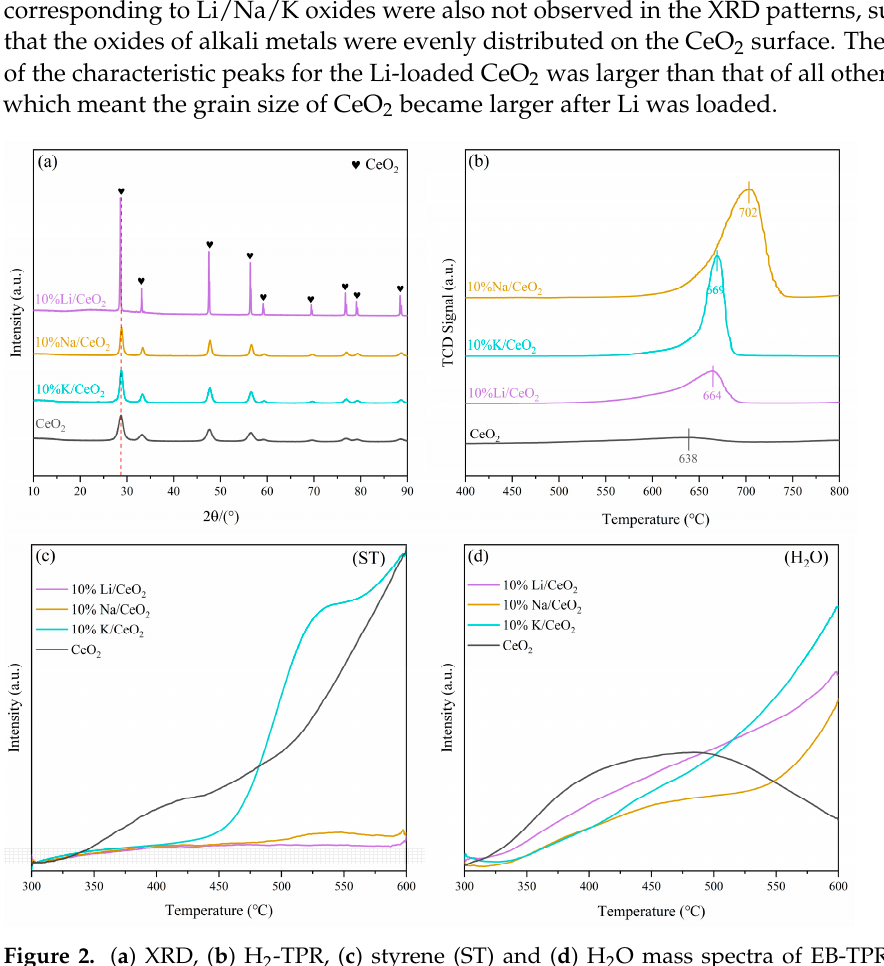
Table 1. Ratio of molar amounts of each reactant required for the enthalpy change Δ H = 0 for the reaction with EB oxidative dehydrogenation under the mixed atmospheric conditions of CO 2 and O 2 .